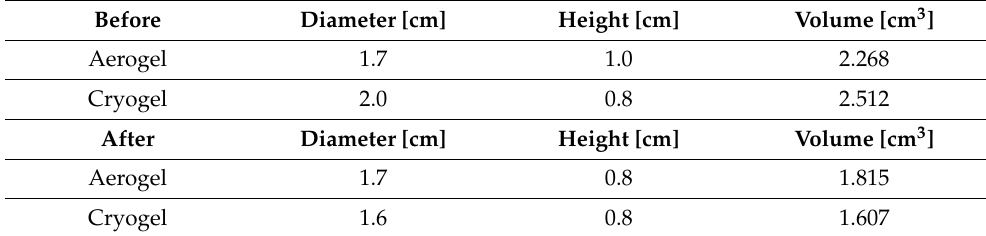
Table 3. Cryo/Aerogel dimensions before and after the drying process.